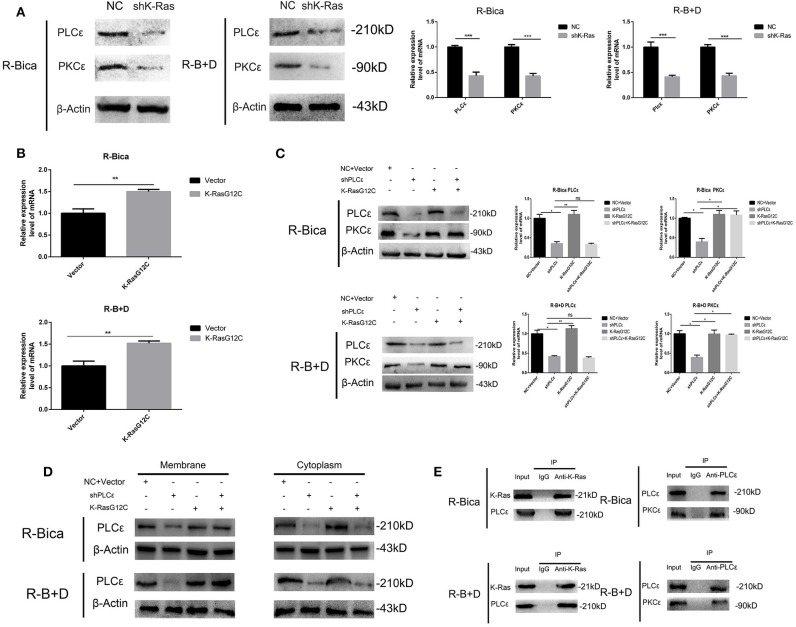
The PLCε, PKCε signaling pathway is regulated by K-RAS. (A) Lentivirus-shK-Ras inhibited the protein and mRNA expression levels of PLCε and PKCε in CRPC cells. (B) Activated K-Ras mutant K-RasG12C mRNA expression level of K-RasG12C (C) Expression of PLCε and PKCε in R-Bica cells and R-B+D cells detected by Western blot and qPCR. Cells were infected with activated K-Ras mutant K-RasG12C or with K-RasG12C combined knockdown of PLCε. (D) The expression of PLCε in Membrane and Cytoplasm in R-Bica and R-B+D cells by Western blot. (E) Co-IP studies were performed with K-Ras, PLCε, and PKC ε in R-Bica and R-B+D cells. sh, small hairpin; shPLCε, PLCε knockdown. Vector, empty vector of overexpression K-RasG12C lentivirus. NC, negative control for Lentivirus-shPLCε.*P < 0.05, **P < 0.01, ***P < 0.001; ns, no statistical significance.